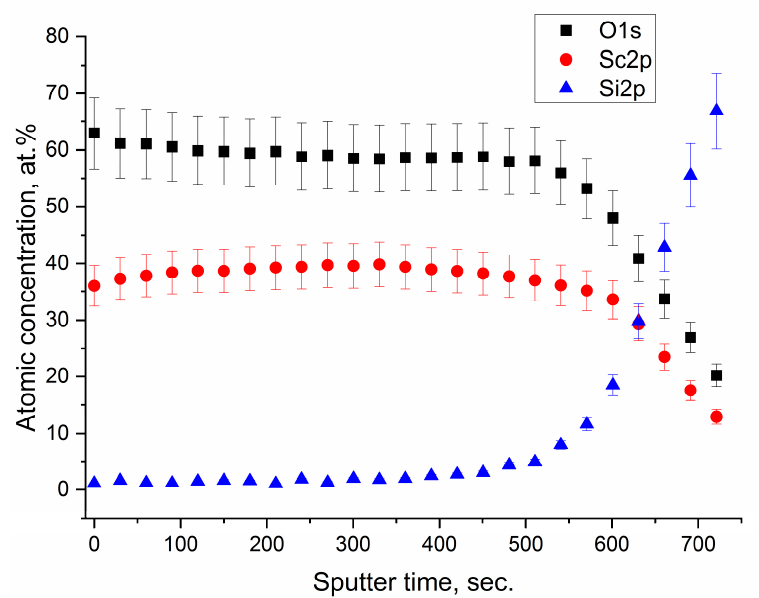
Figure 4. XPS depth profile of the sample SCO-30.